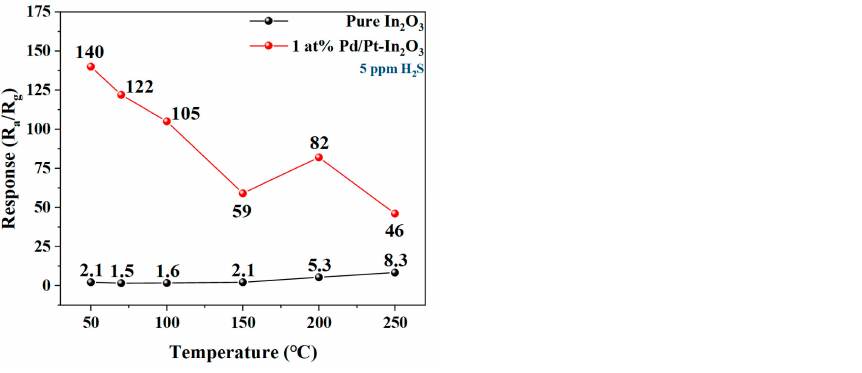
Figure 5. Response of pure In 2 O 3 and 1 at% Pd/Pt-In 2 O 3 to 5 ppm H 2 S at different